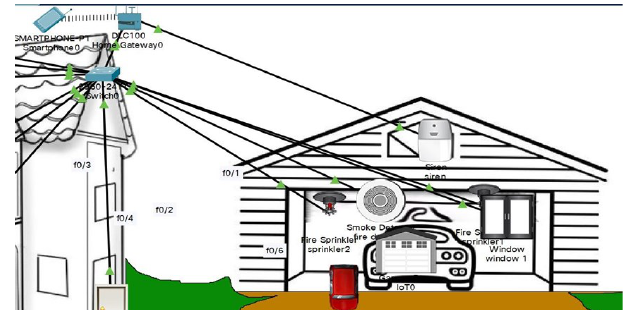
Fig. 2. Depicts the list of devices on the IoT Server that are connected to the